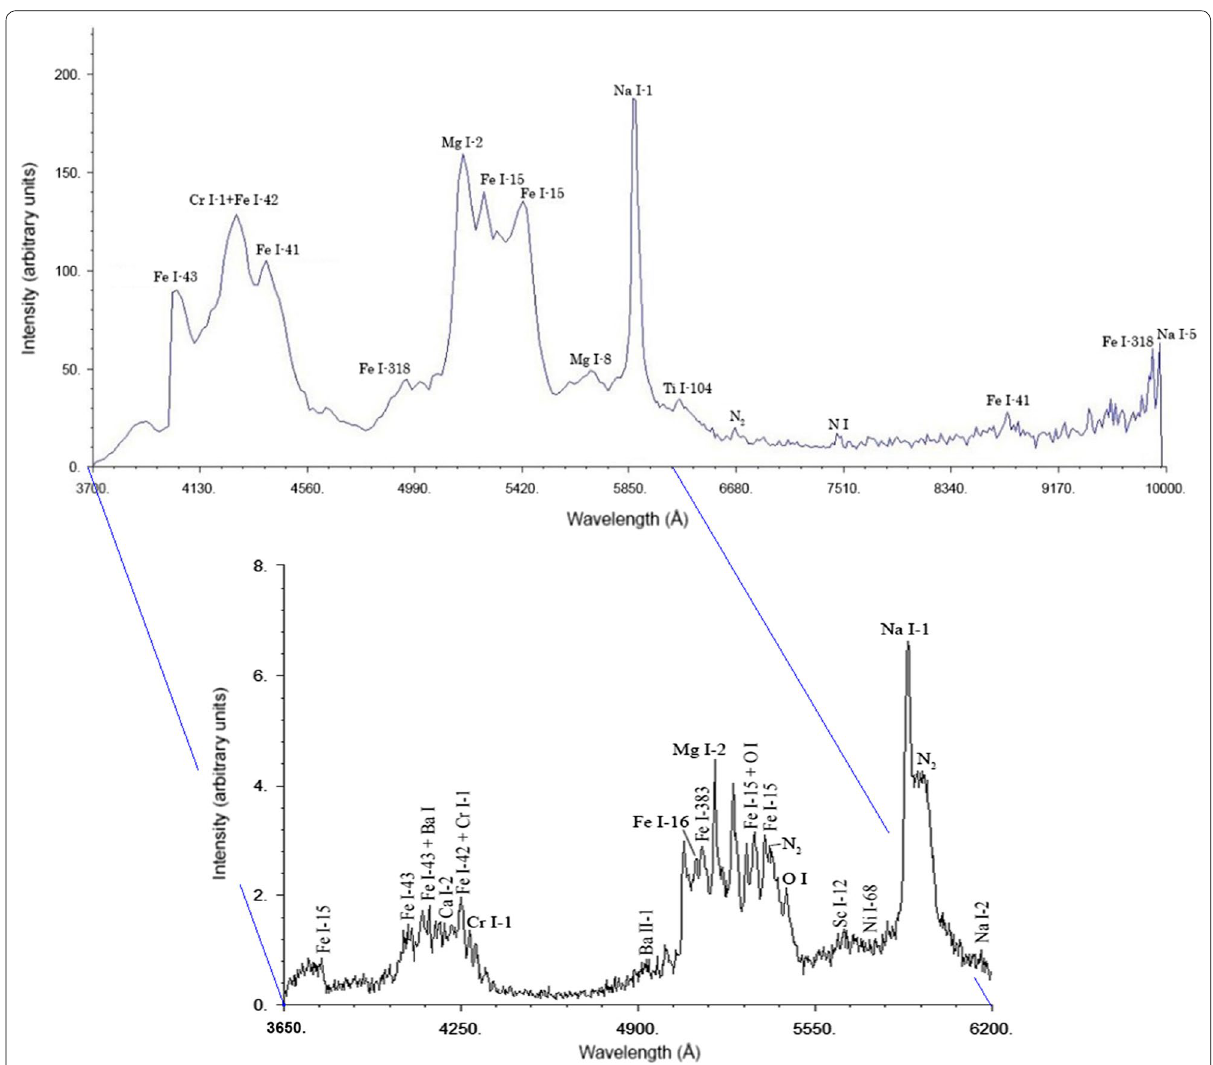
Fig. 4 Calibrated emission spectrum of the M20160930_213851 fireball, obtained simultaneously by the spectrograph #1 (top panel) and the spectrograph #2 which provides higher spectral resolution (lower